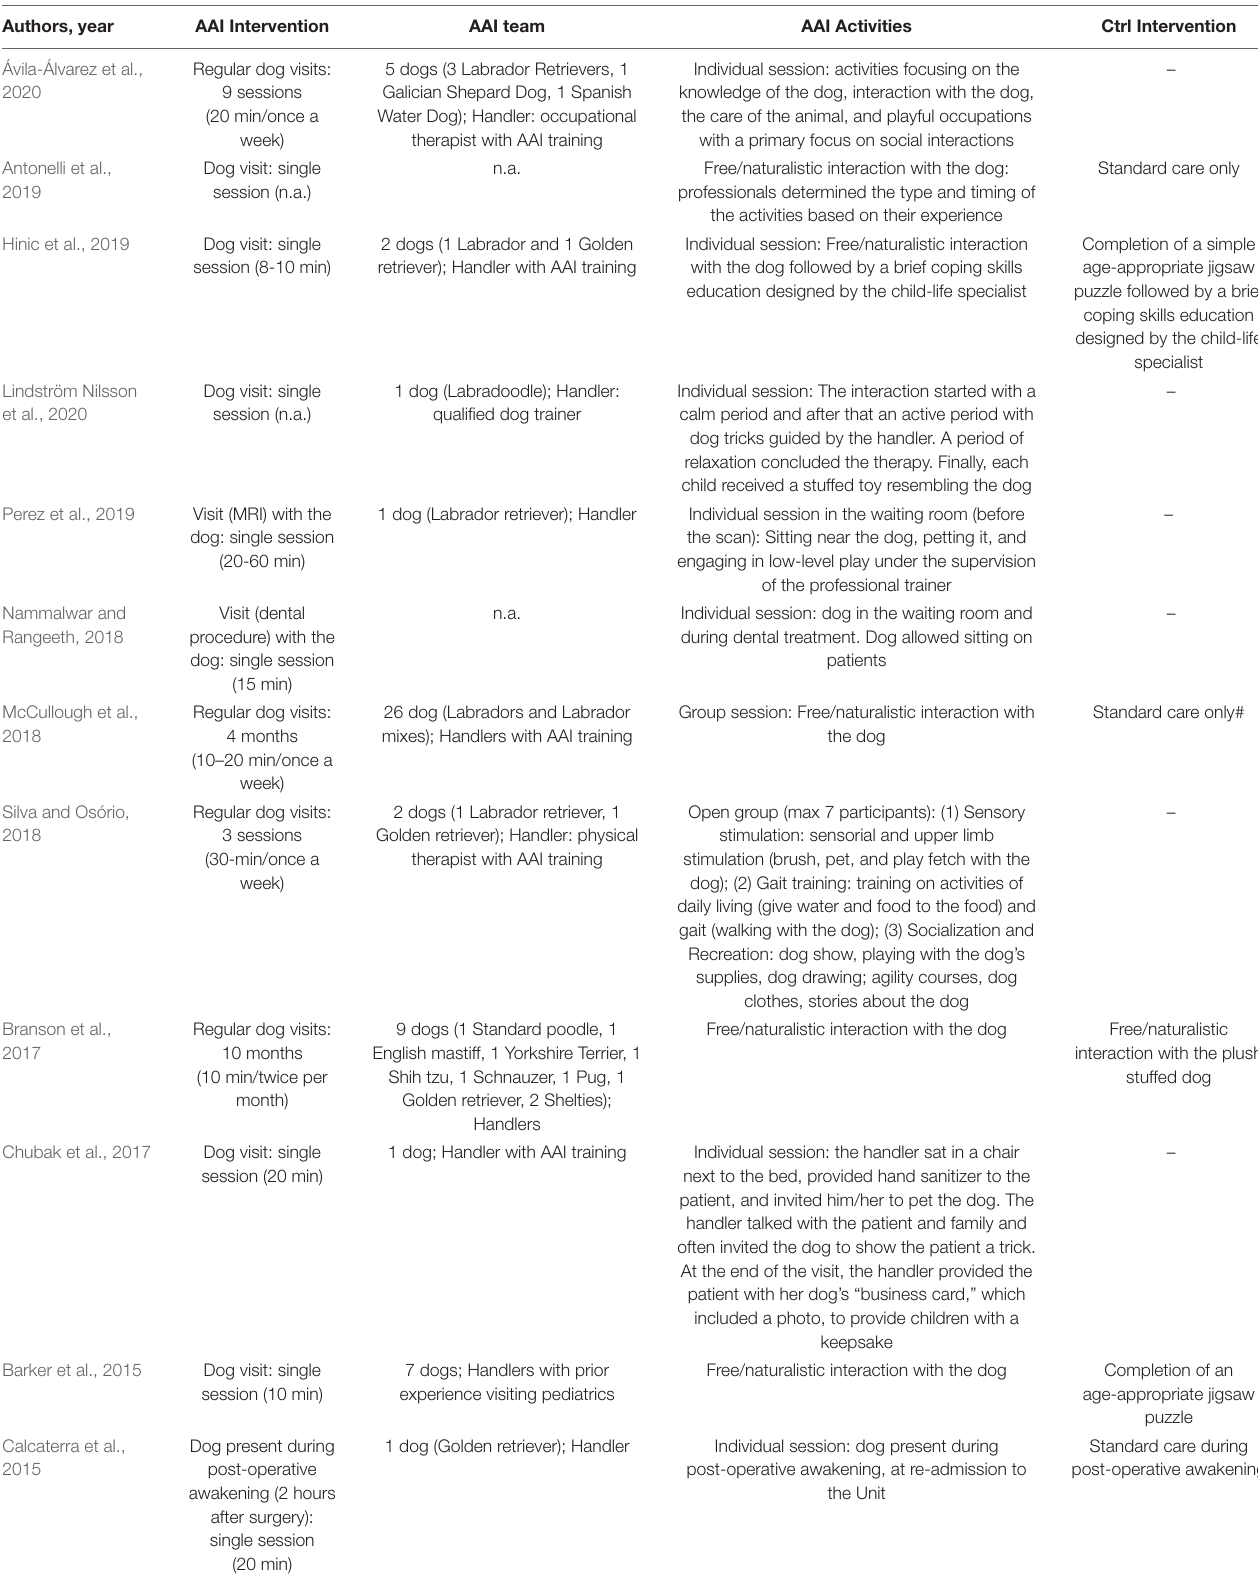
TABLE 2 | Intervention characteristics of the included